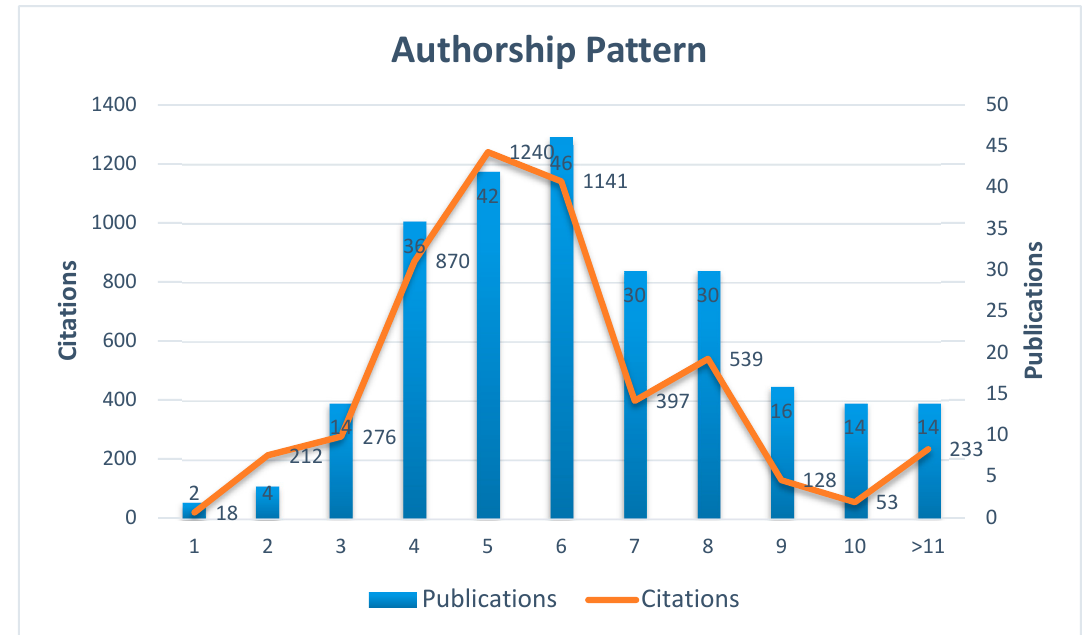
Figure 3. Authorship pattern of antibacterial dental adhesive literature. Polymers 2020 , 12 , x FOR PEER REVIEW